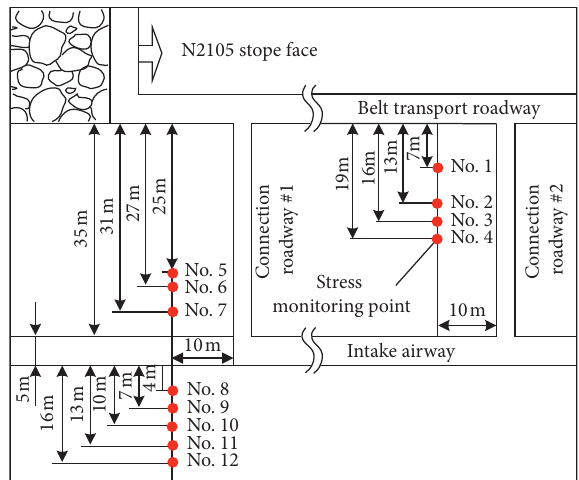
Figure 7: Installation plan of stress monitoring